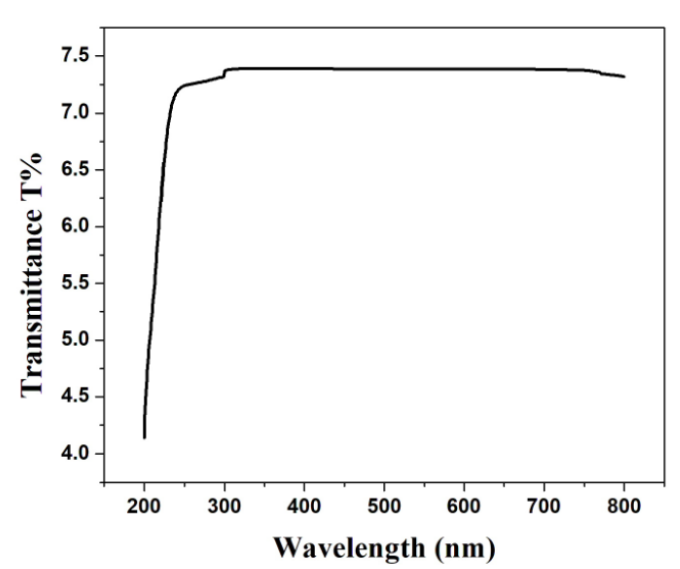
Figure 3. Transmittance spectrum of UGA.